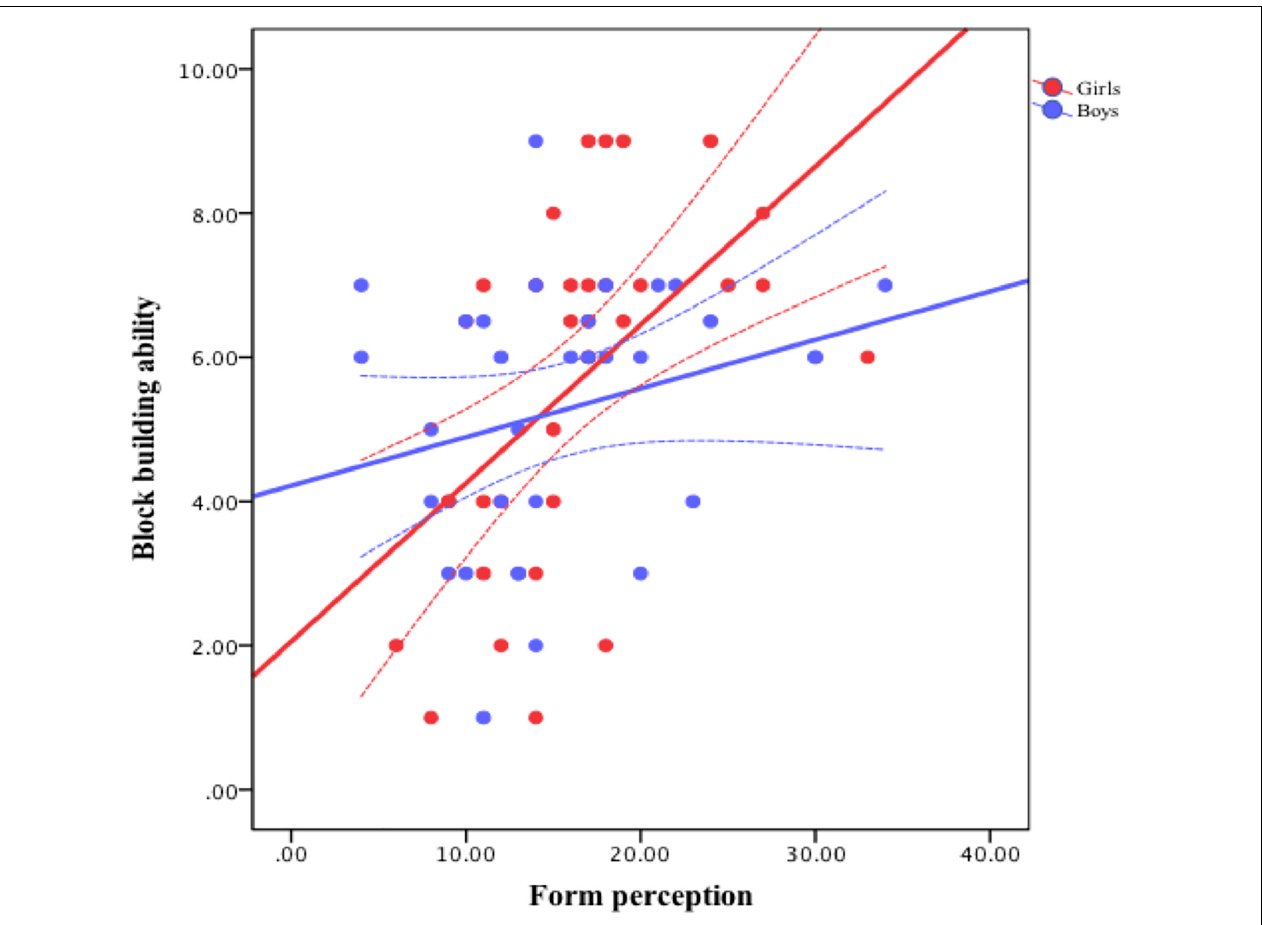
FIGURE 5 | The association between form perception and block building ability by